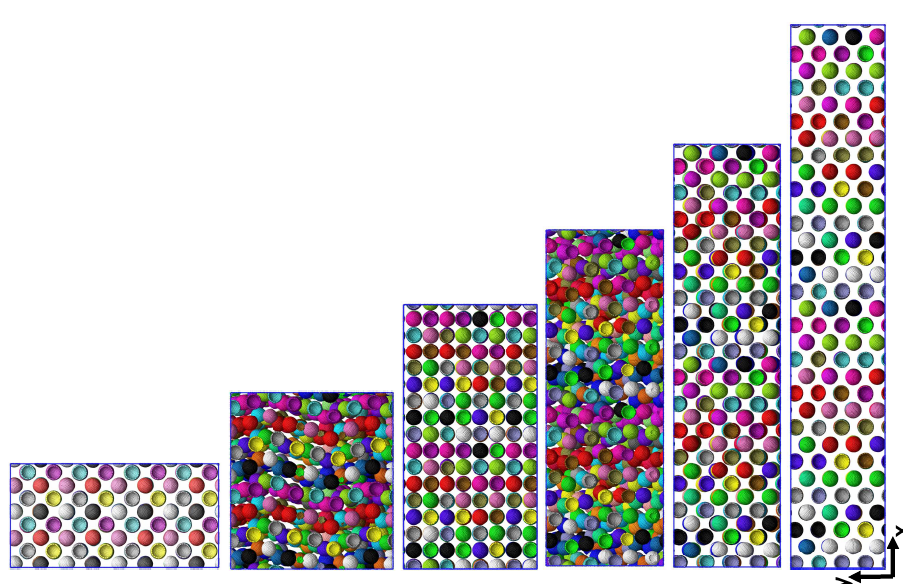
Figure 12. L2 ◦ system at strain rate ˙ (cid:101) xx = 0.001, captured at different stretching strains of (cid:101) xx = 0, 68%, 150%, 220%, 300%, and 410% from top to bottom respectively. Polymers are not shown here for the sake of clarity. The corresponding NP–NP pair correlation functions, stresses, and disorder parameters at these strains are given in Figure 11. All the coordinates here are projected onto the xy plane. We have chosen only to show L2 ◦ here; the snapshots are very comparable for L2 • , as Figure 11c also